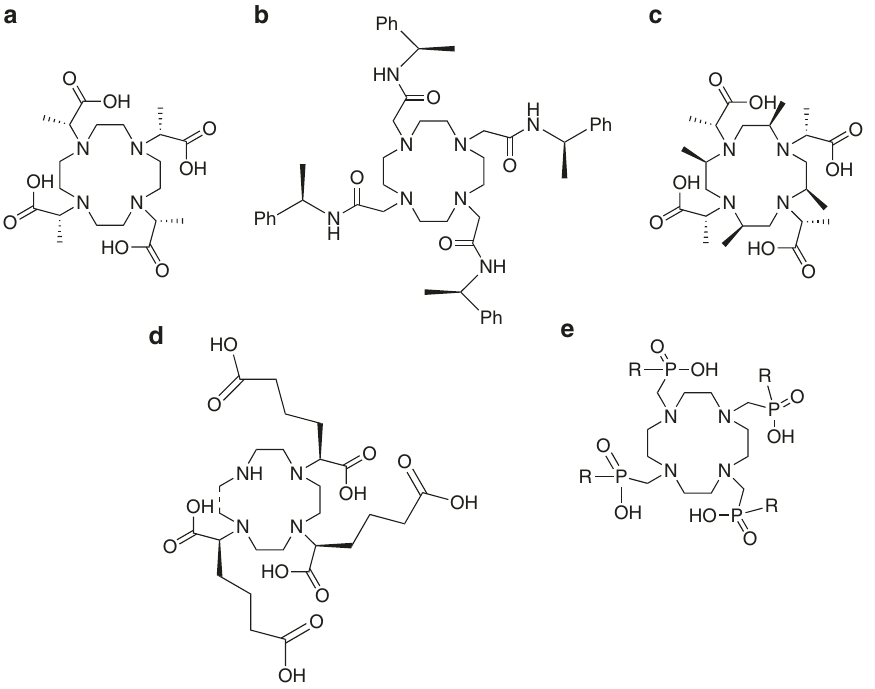
Fig. 4 Ligands where chirality has been introduced into the pendant arm of the N4-macrocyclic ring. Substitution onto the arms can hinder isomer interconversion by preventing arm rotation and encouraging preference for a speci fi c complex geometry. a H 4 dotma (all R ), featuring a methyl group at the alpha position of the arm. b DotamPh ( R ), featuring a chiral substituent on each pendant arm. c H 4 Me 4 dotma (all R ), where there is introduction of chirality into both the cyclen-N4 ring and the pendant acetate arms. d H 6 R,R,R -gado3a, with only three pendant arms, each of which is modi fi ed at the alpha position. e H 4 dotp R (R = OH, H 8 dotp, R = H, H 4 dotp H , R = O- n Bu, H 4 dotpmb), where chirality is introduced via phosphinic or phosphonic acid pendant arms. Stereochemistry is added where